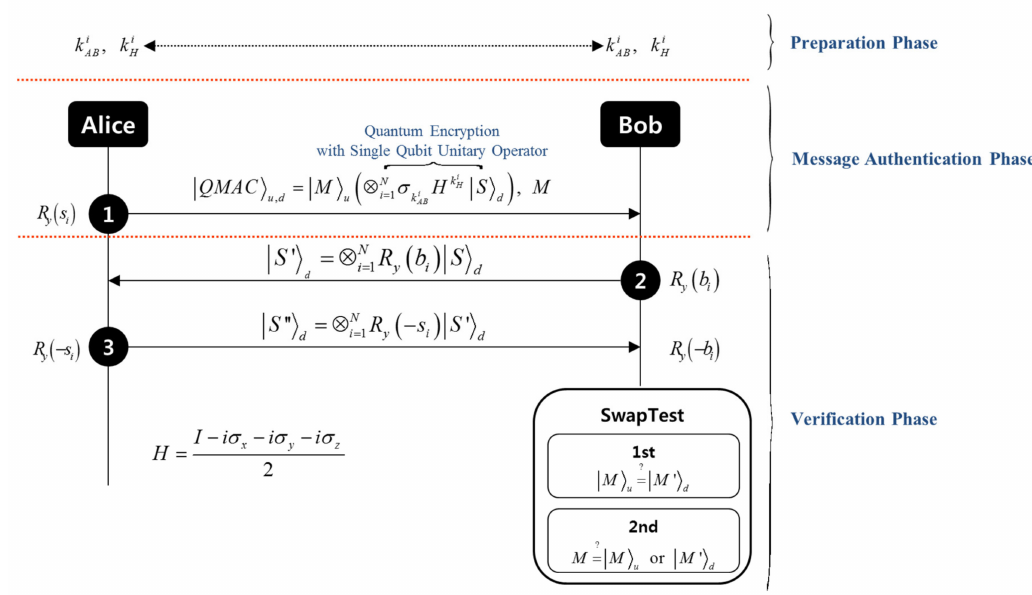
= ⊗ N R y ( m i ) | ϕ (cid:105) i u u i = 1